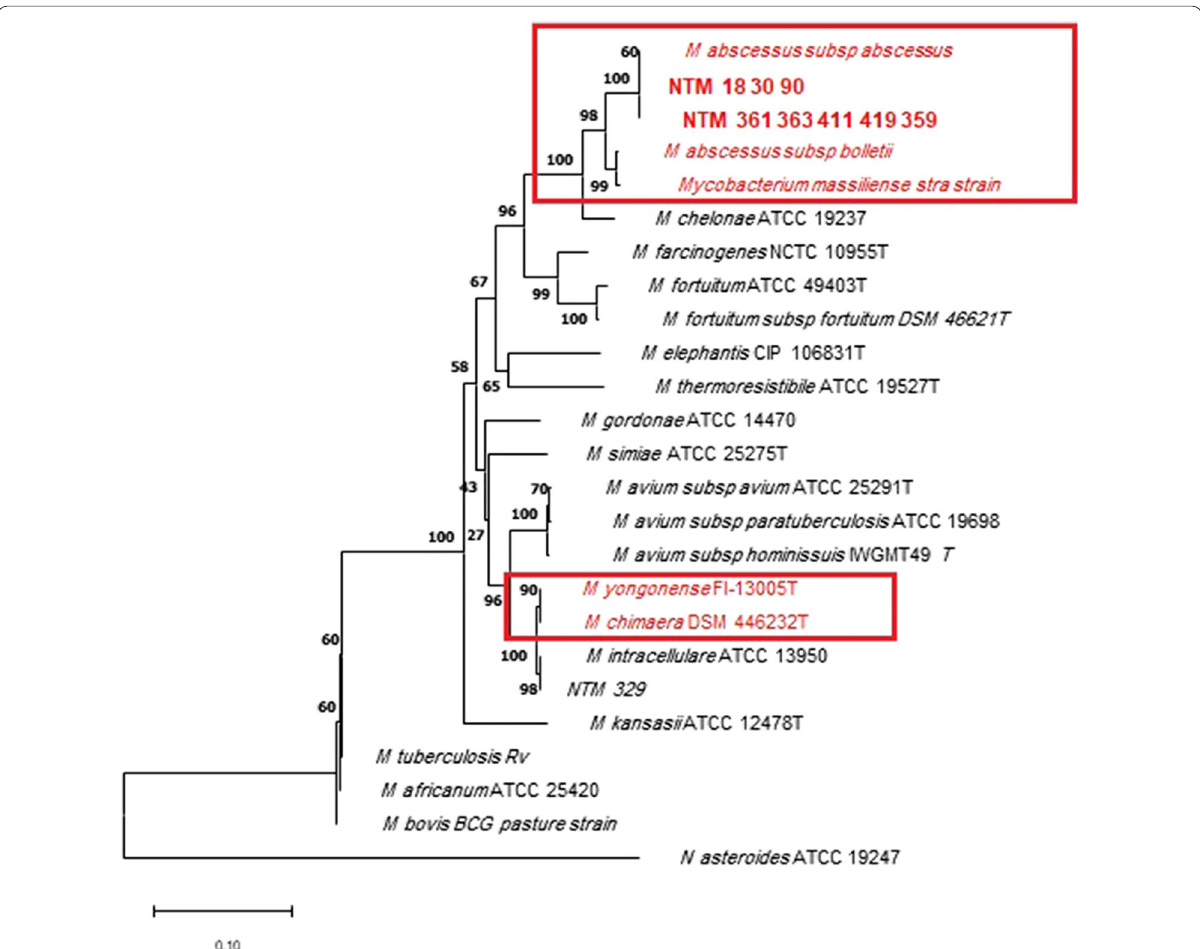
Fig. 1 Phylogenetic relationship (evolutionary tree) of clinical isolates of nontuberculous Mycobacteria based on rpoB gene sequencing (the maximum likelihood tree generated using the Tamura 3-parameter model in MEGA11 software). Boxes are represented of isolates that could not